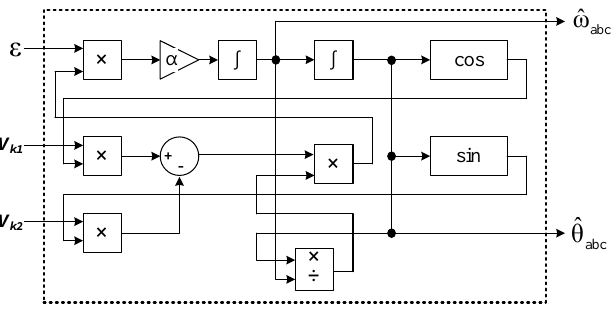
Figure 7. Block diagram of the frequency estimation